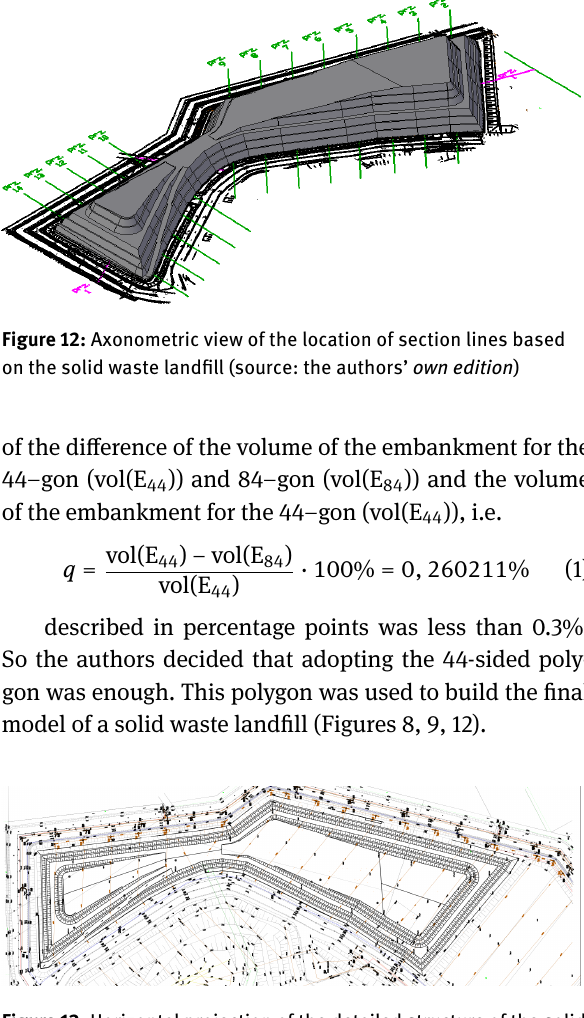
Figure 13: Horizontal projection of the detailed structure of the solid waste landfill (source: the authors’ own edition